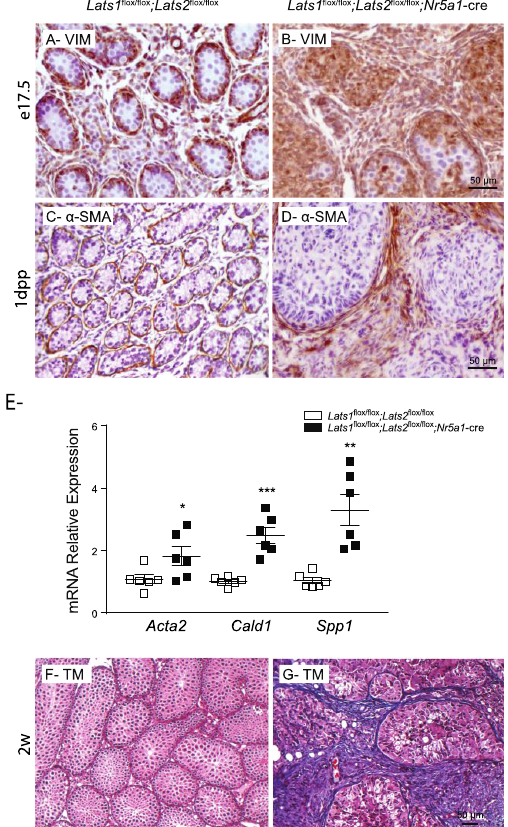
Figure 8. Loss of Lats1 and Lats2 leads to fibrosis in the testis interstitial tissue. ( A , B ) Im- munohistochemical analysis of VIM expression in testes of e17.5 mice of the indicated genotypes. ( C , D ) Immunohistochemical analysis of α -SMA expression in testes of 1dpp mice of the indicated genotypes. ( E ) RT-qPCR analysis of myofibroblast markers in testes of 1dpp mice of the indicated genotypes ( n = 6 animals/genotype). All data were normalized to the housekeeping gene Rpl19 and are expressed as means (columns) ± SEM (error bars). Asterisks = significantly different from control (* p < 0.05; ** p < 0.01; *** p < 0.001). ( F , G ) Masson’s trichrome staining of 2-week-old mice of the indicated phenotype. Scale bars in the right panels are valid for the left